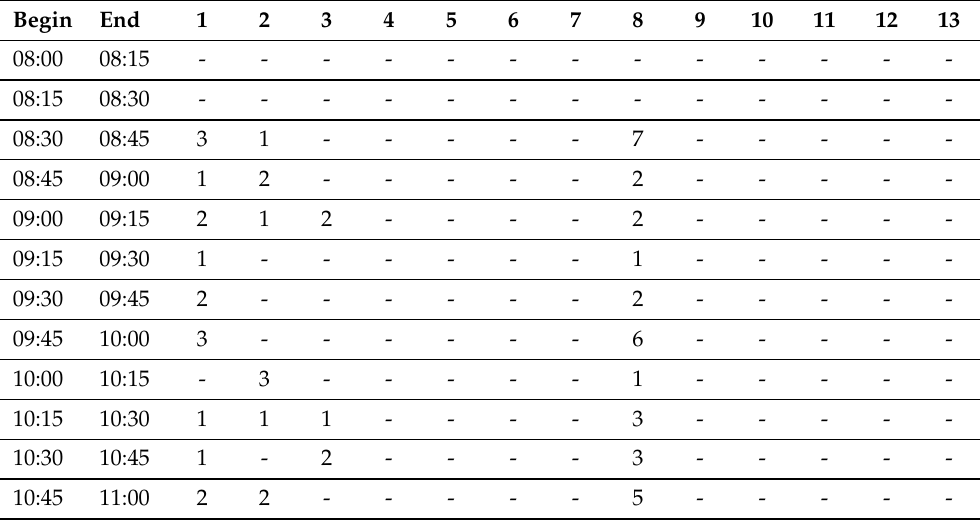
Table 8. Number of occurrences, by choreography